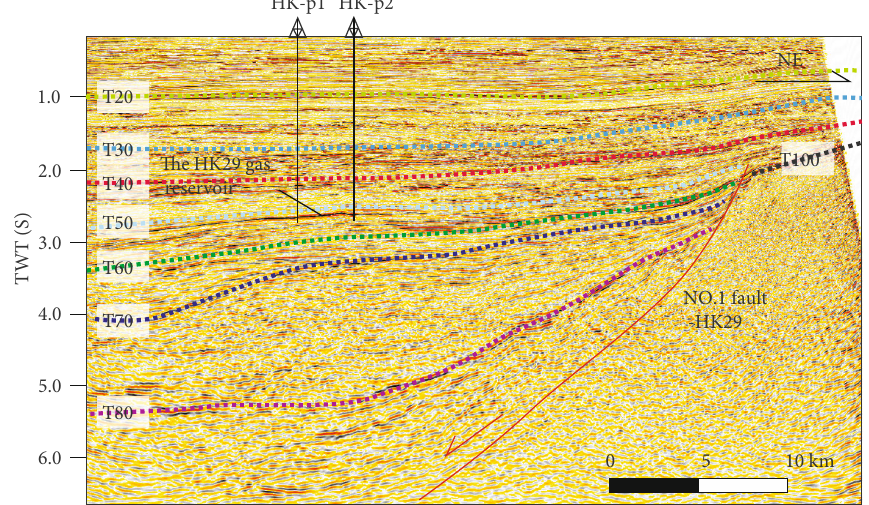
Figure 7: The NE-oriented seismic section (L1) of the HK29 gas reservoir reveals that the No. 1 fault is an independent fault structure that contains no branching faults on the hanging wall. The section location is shown in Figure 1. Our 3D seismic data extend as deep as